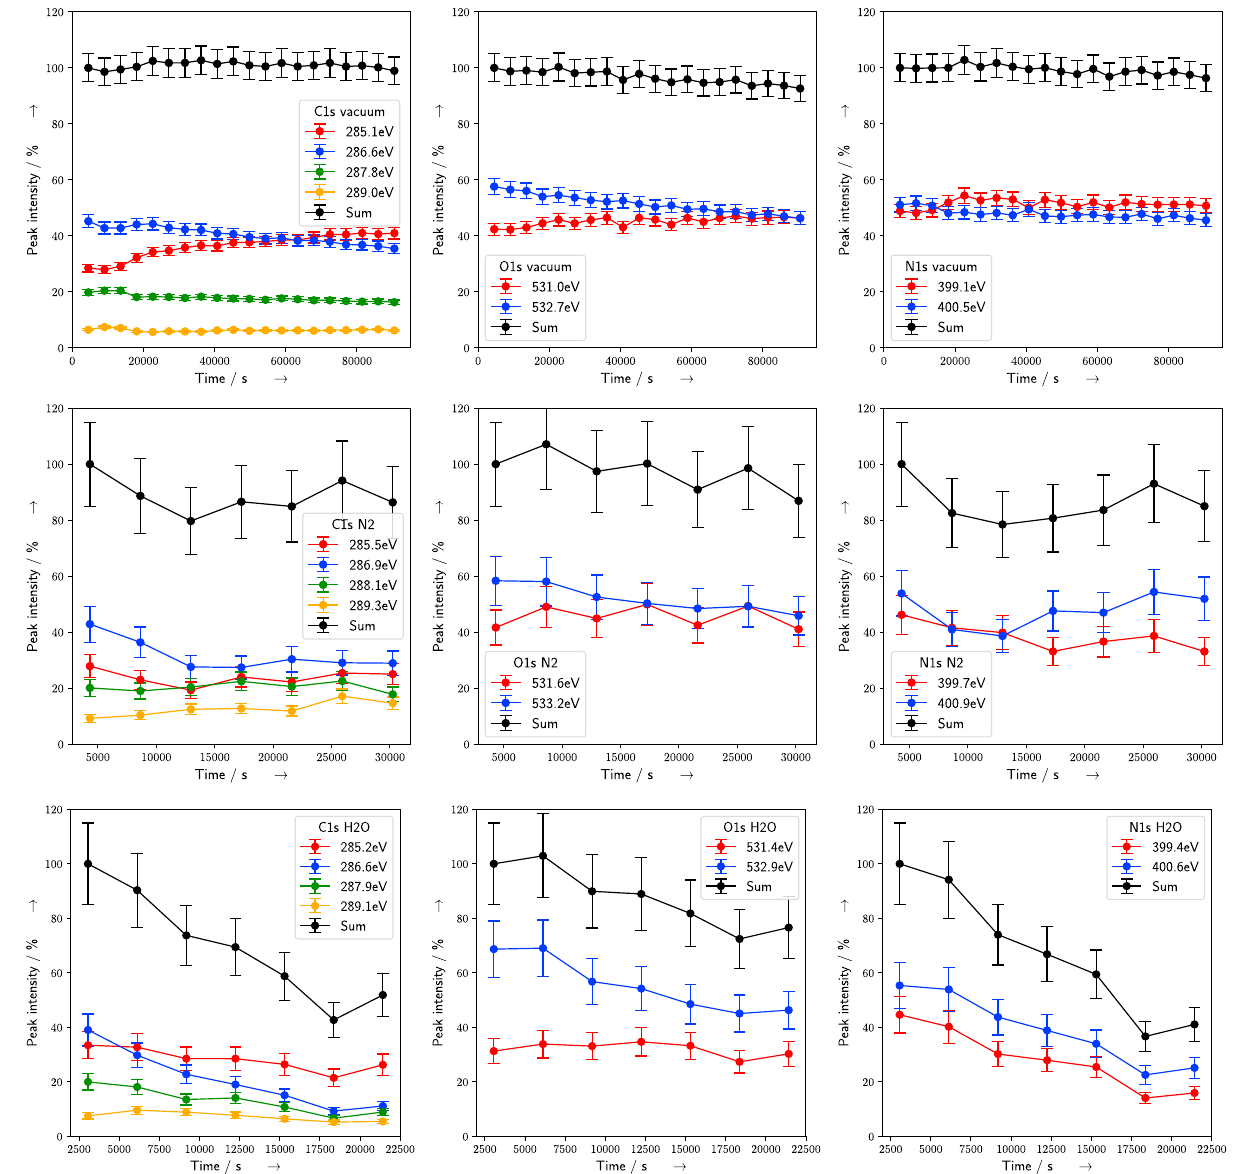
Fig. 4 Time dependent normalized peak areas of XPS signals. Evolution of XPS signals at C1s (left column), O1s (center column), and N1s (right column) binding energies are shown for vacuum (top row), N 2 (center row), and H 2 O (bottom row) conditions. Intensities were normalized on the P2p signal (compare SI, Fig. S3) at the same time. The percentage of the intensity is given with respect to the total integrated peak area at the beginning of the irradiation. Assignments are according to Table 1. Error bars were determined using a matrix inversion approach (compare SI, Sec. 1.4). Lines are guides to the